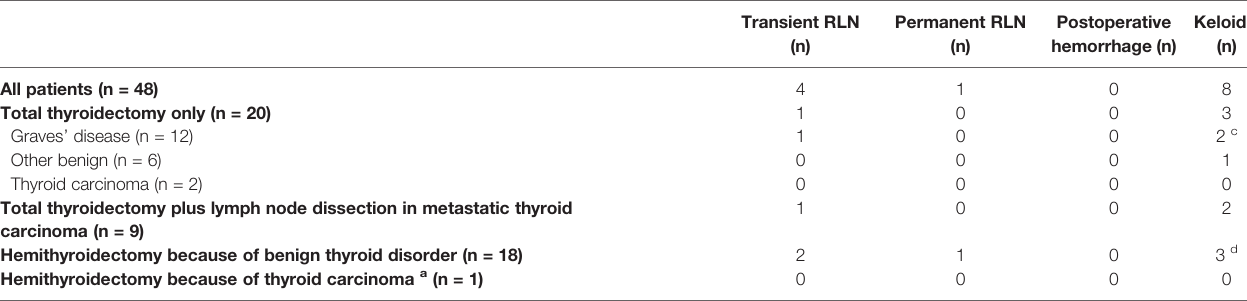
TABLE 3B | Postoperative complications in pediatric patients who underwent a